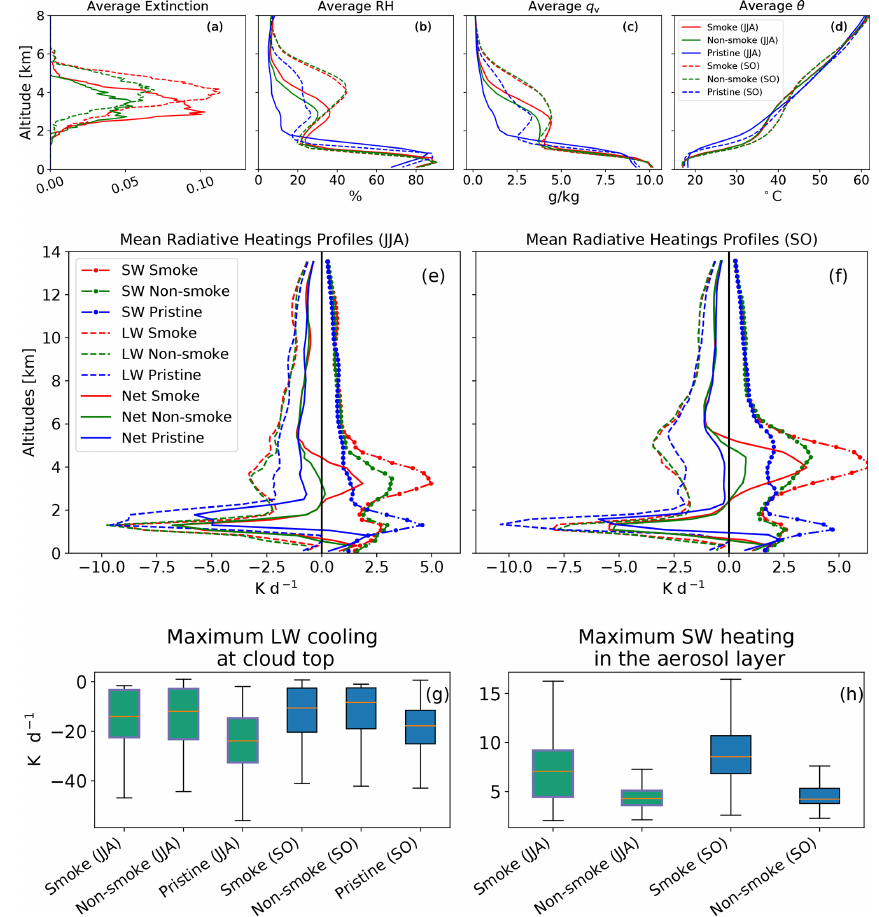
Figure 5. (a–d) Mean profiles of aerosol extinction, relative humidity (RH), specific humidity ( q v ), and potential temperature ( θ ) for the smoke, non-smoke, and pristine cases during June–July–August (JJA) and September–October (SO) during the period 2007–2010. RH, q v , and θ are derived from atmospheric variables in the CloudSat ECMWF-AUX product. (e, f) Mean shortwave (SW), longwave (LW), and net (Net) radiative heating profiles for the same cases and periods. (g, h) Box plots showing maximum, minimum, median, and first and third quartiles of the maximum LW cooling at cloud top (g) and the maximum SW heating in the aerosol layer (h) for the smoke, non-smoke, and pristine